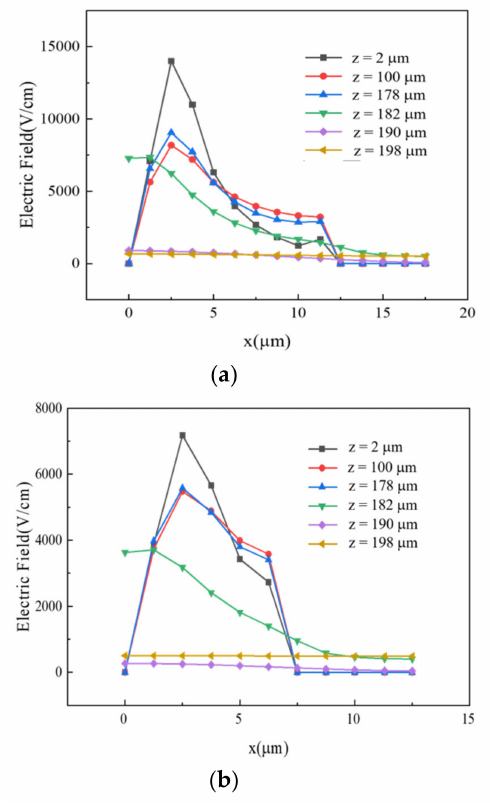
Figure 8. Electric field curves for di ff erent detector structure thicknesses with electrode spacings of ( a ) 10 µ m and ( b ) 5 µ